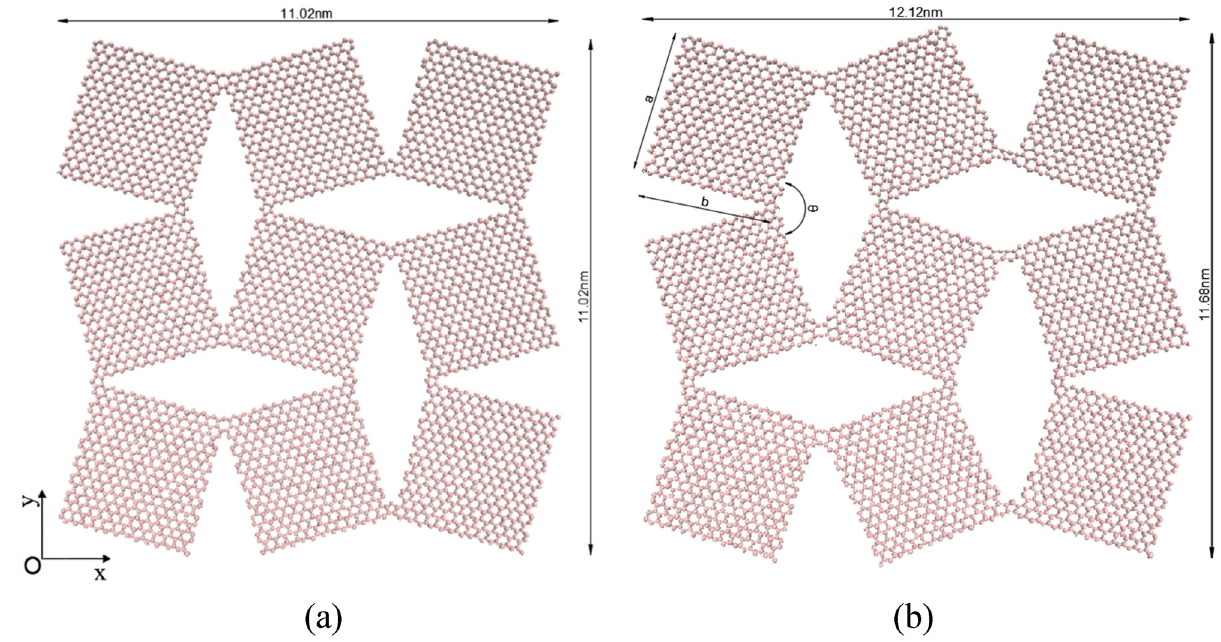
Figure 5: ( a ) PRGNs in an equilibrium state; ( b ) PRGNs when the strain is 0.1 ( a = b = 3 nm, θ = 150° )